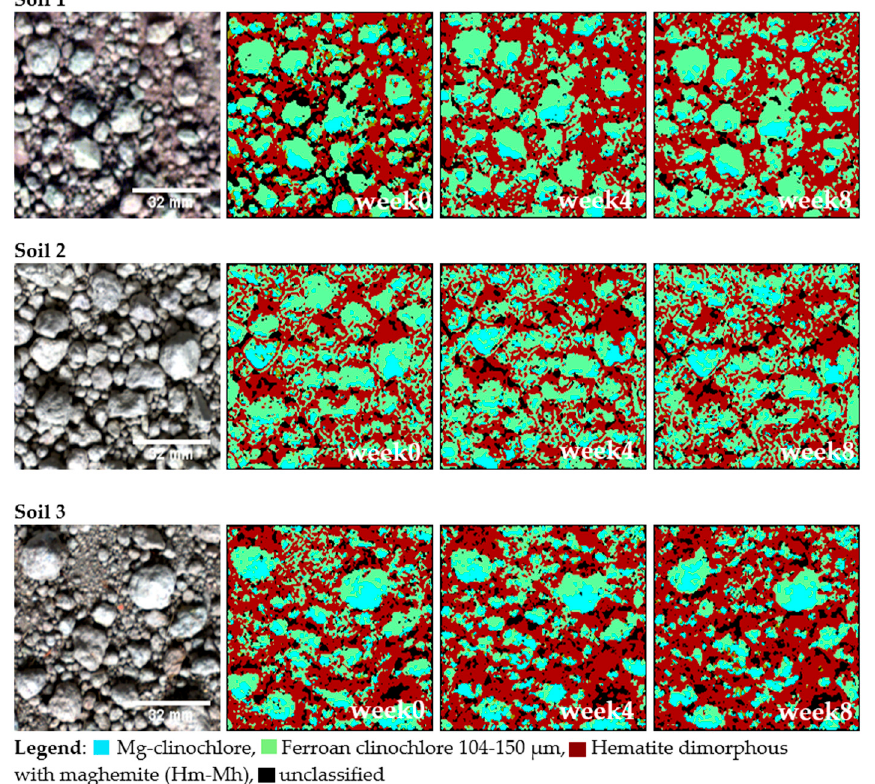
Figure 5. Example of the SID classification results at the drying-field capacity (D-FC) treatment at the start (week 0), middle (week 4) and the end of the experiment (week 8) in the dry conditions (Soil 1– Soil 3). The colors represent the minerals identified in the VNIR. All the soils show changes in their mineral distribution over time. The original images at the start of the experiment, together with the scale bar, are also shown.